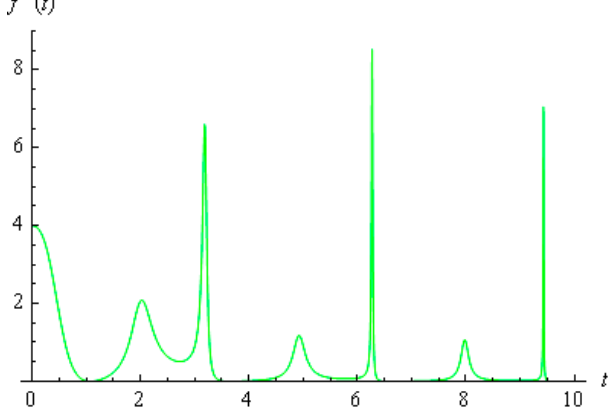
Figure 2. The entropy Entrp( ) N is finite.